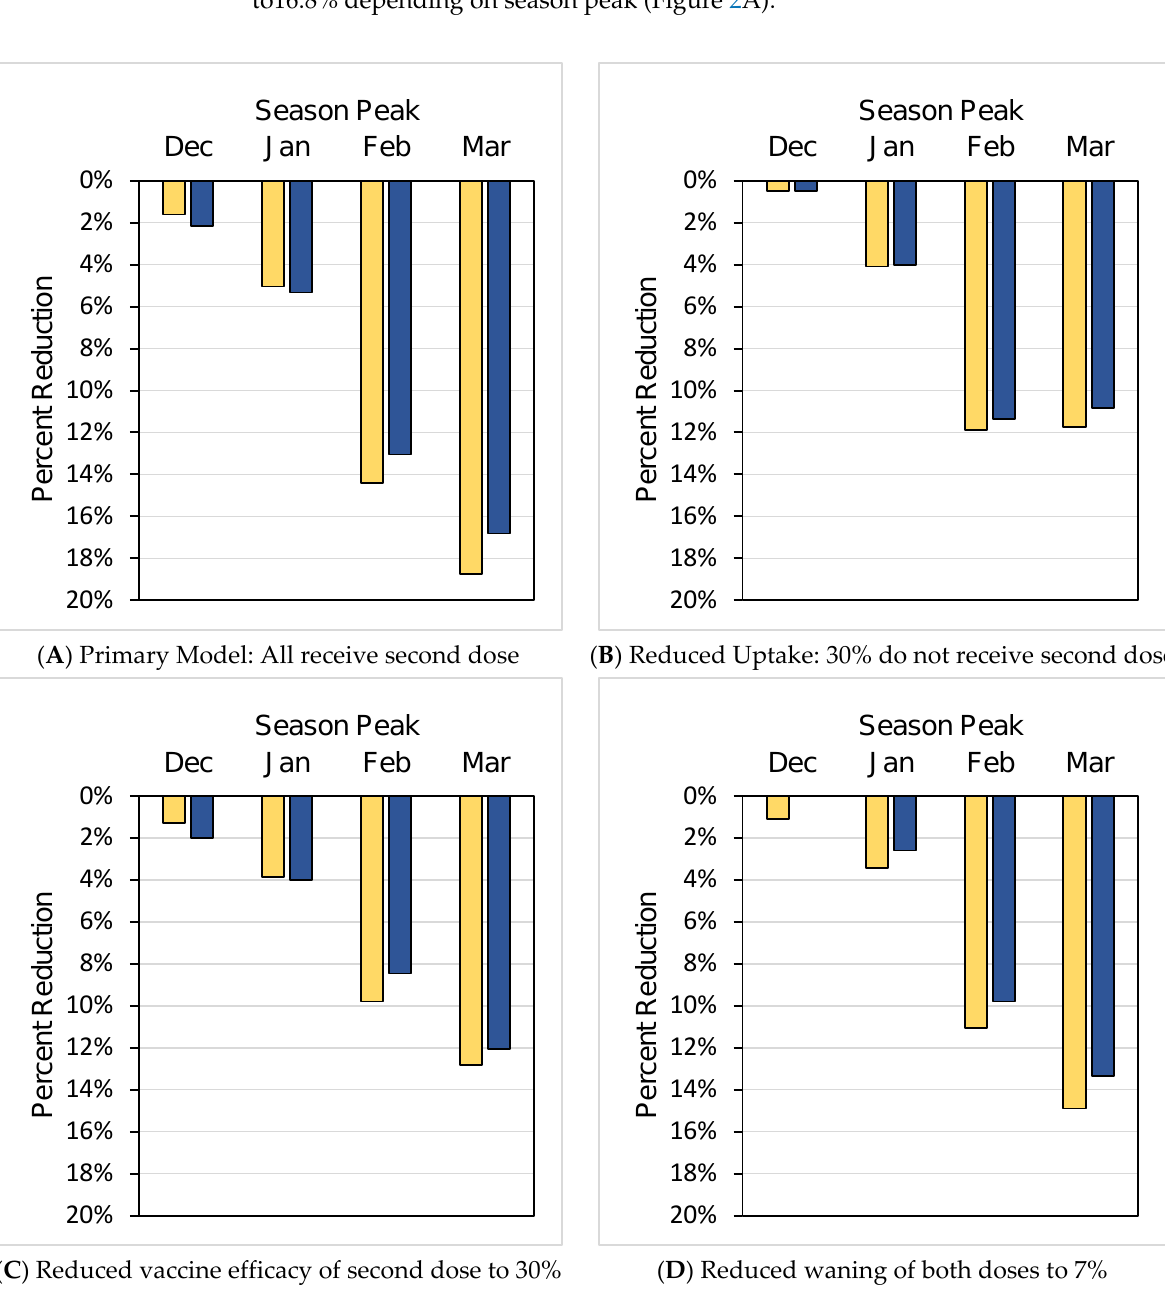
Figure 2. Percent reduction in cases and hospitalizations age 65 and up per 100,000 population with two vaccine doses by season peak. Yellow bars represent cases and blue bars represent